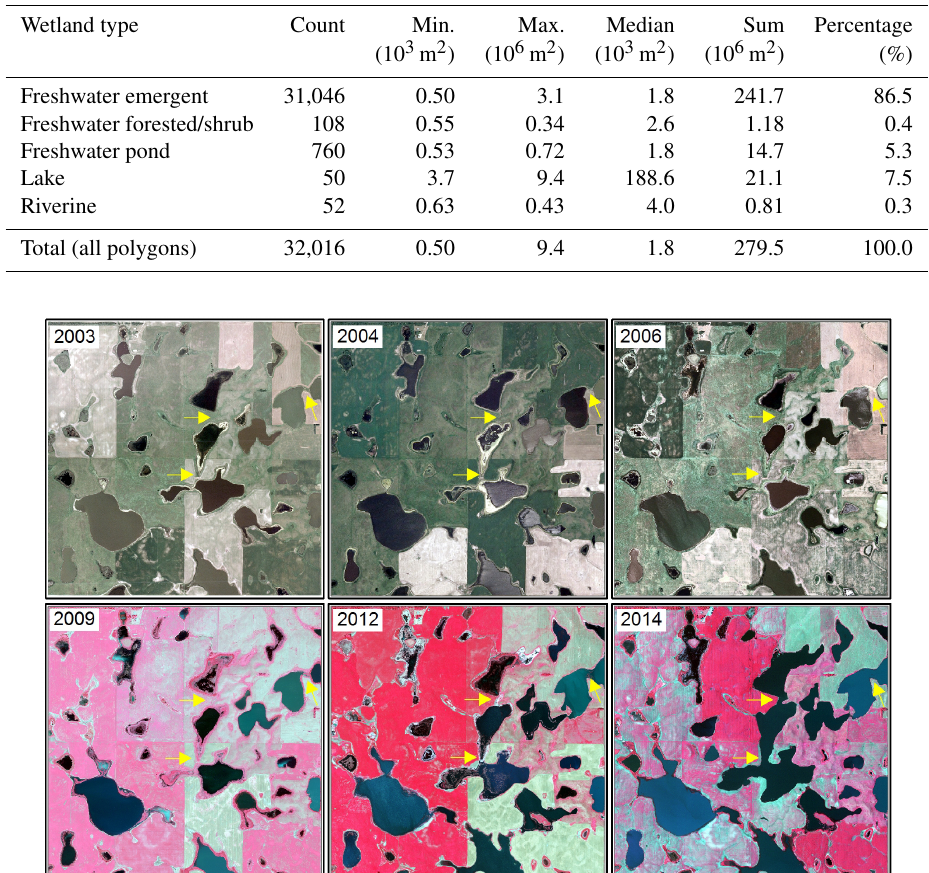
Figure 2. Examples of the National Agriculture Imagery Program (NAIP) aerial imagery in the prairie pothole region of North Dakota illustrate the dynamic nature of prairie pothole wetlands under various dry and wet conditions. The yellow arrows highlight locations where filling–spilling–merging dynamics occurred (imagery location: 47 ◦ 1 (cid:48) 23.519 (cid:48)(cid:48) N, 99 ◦ 8 (cid:48) 34.454 (cid:48)(cid:48)